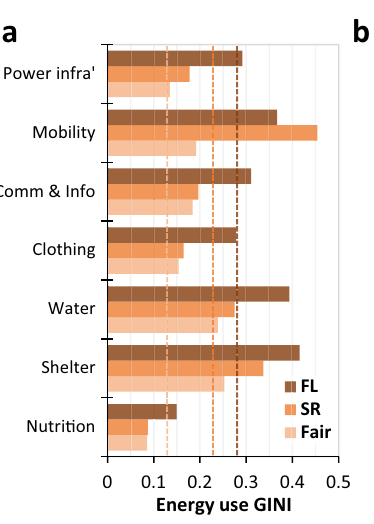
Fig. 3 | Energy inequality for different sectors and the composition of total energy use. Panel a shows GINI coef fi cients of 2050 global fi nal energy use across consumptioncategoriesfortheinequalityscenarios(DLEisomittedasinequalities are negligible). The vertical lines indicate GINI coef fi cients for total energy use for each scenario. Panel b shows the sectoral breakdown of global energy use for the